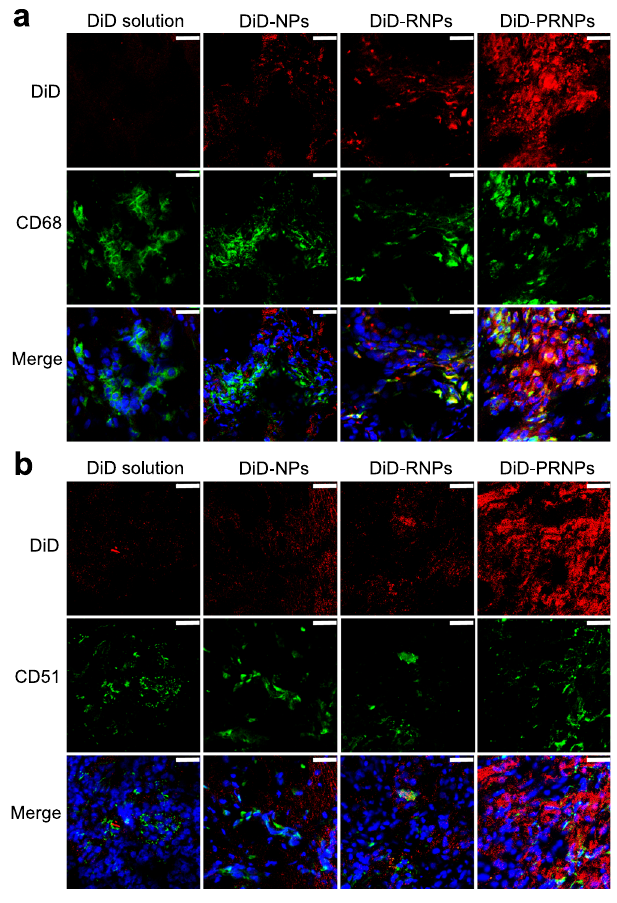
Fig. 6 PRNPs are selectively distributed in OCs and in fl ammatory macrophages in arthritic joints of rats with advanced arthritis. Confocal images showing the distribution of different DiD formulations in synovial macrophages ( a ) and OCs ( b ) in in fl amed joints. Macrophages and OCs were determined by immuno fl uorescence analysis of CD68 and CD51 (green fl uorescence), respectively. (Scale bar = 25 μ m) ( n = 3